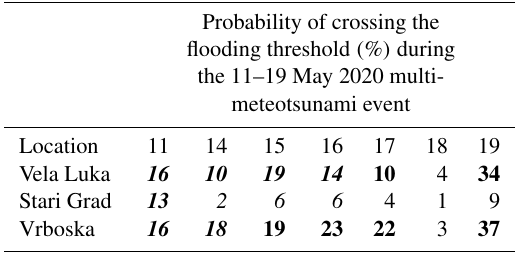
Table 2. Meteotsunami hazard assessment derived with the stochas- tic surrogate model and provided as the probability of maximum sea elevation crossing the flooding thresholds in Vela Luka, Stari Grad, and Vrboska during the 11–19 May 2020 period. Probability of crossing the flooding threshold ( % ) during the 11–19 May 2020